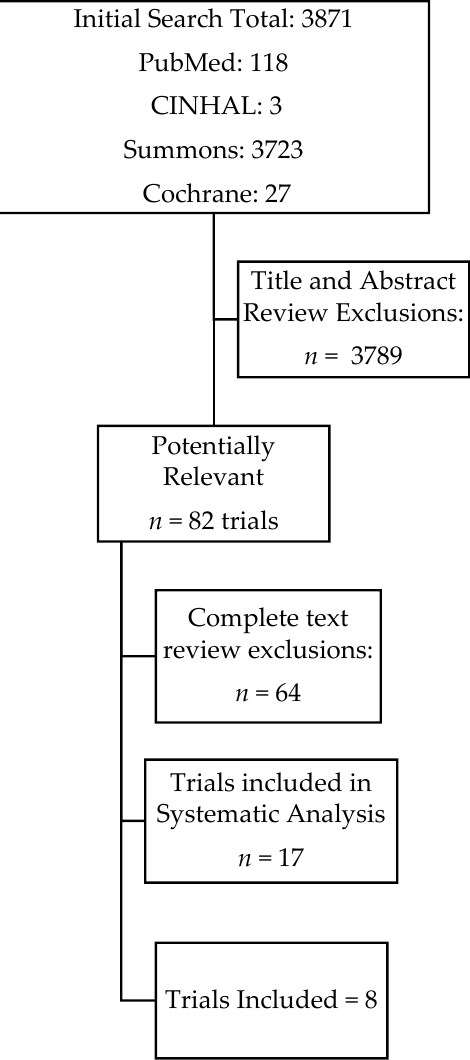
Figure 1. Flowchart for the process of identification of trials.